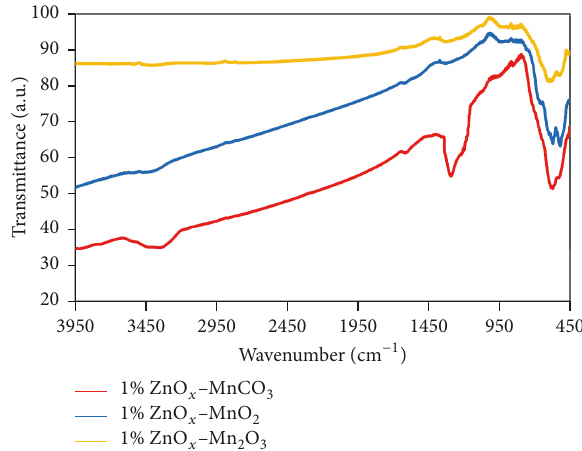
Figure 4: FTIR spectra of the catalyst calcined at different temper- atures 1% ZnO –MnCO 3 ; 1% ZnO x